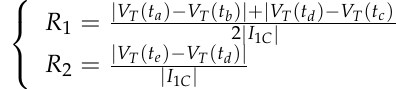
Figure 4. Terminal voltage of battery after discharging current pulse.